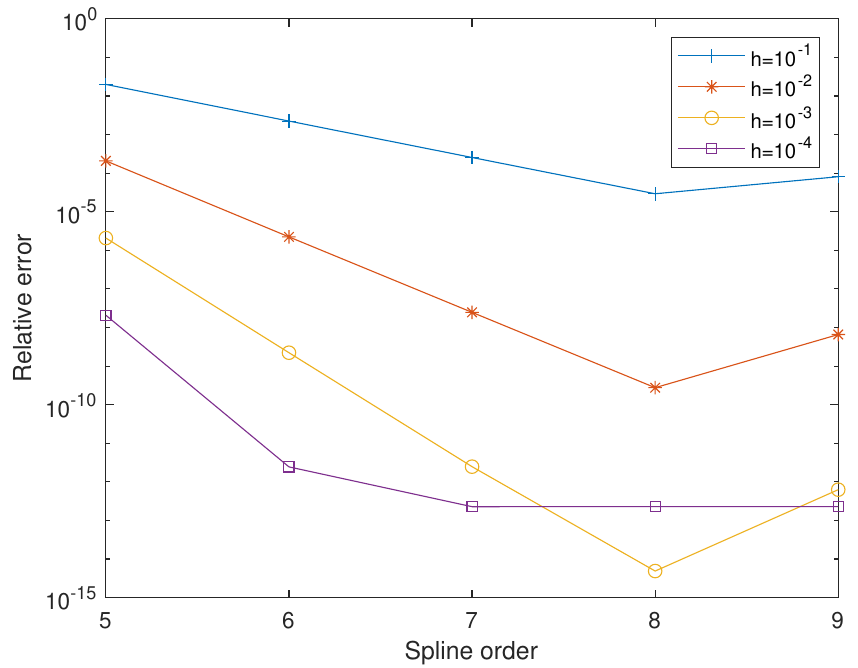
Figure 4. Relative errors at